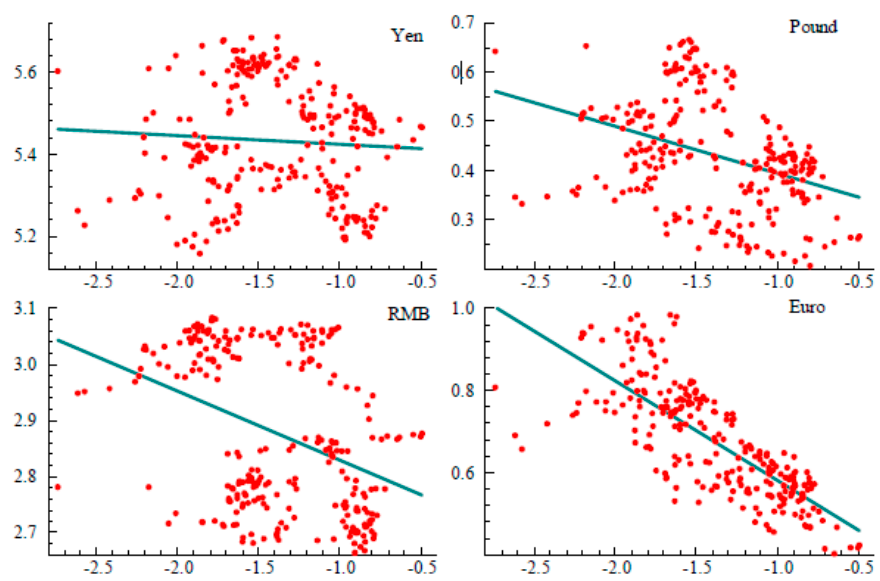
Figure 5. The horizontal axis represents the WTI price of oil deflated by the U.S. CPI; the vertical axis for each panel represents the bilateral exchange rate adjusted by movements in that currency’s CPI relative to the U.S. CPI. Variables are in logarithms.